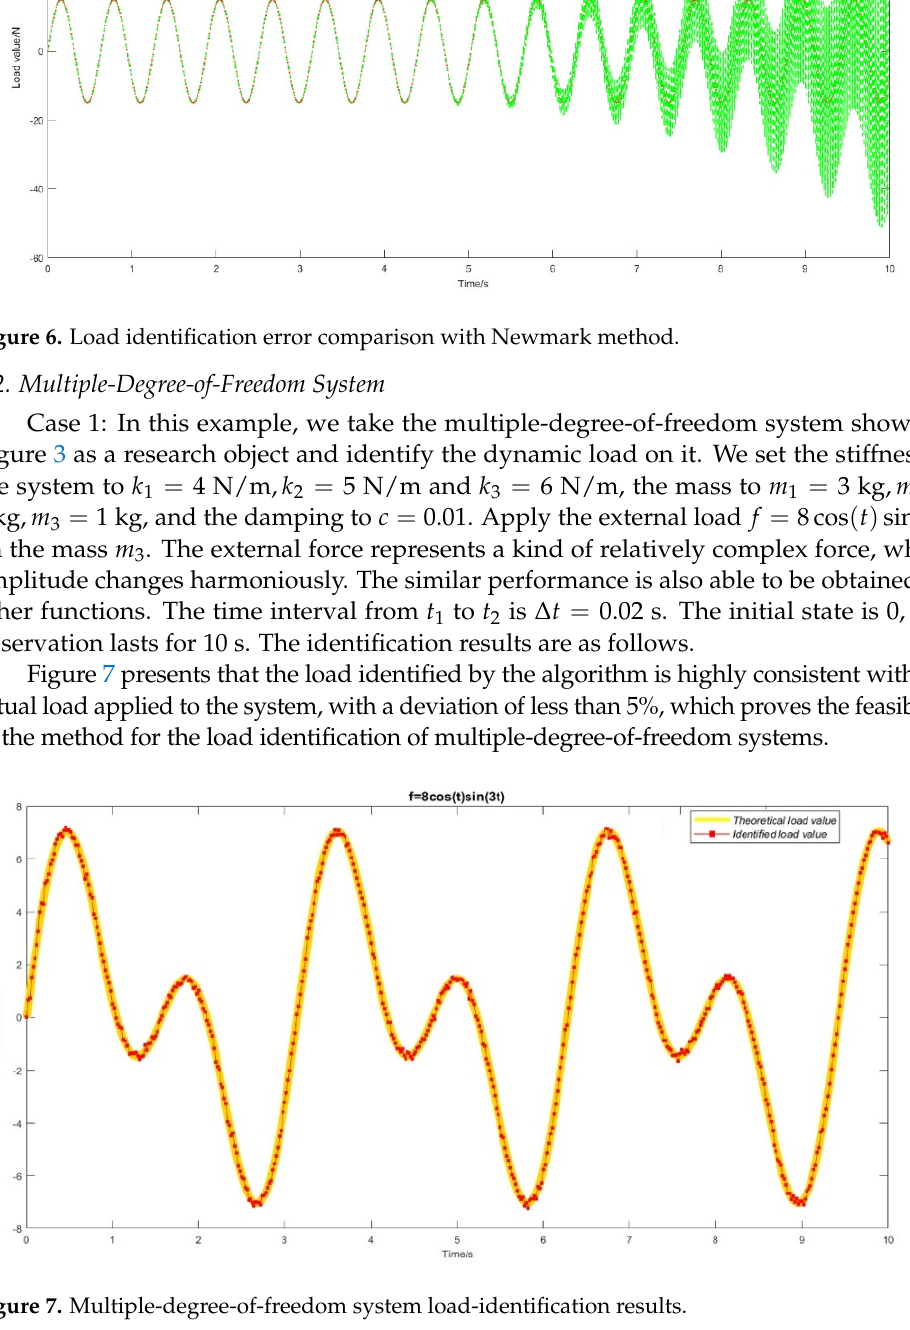
7 of 13 Figure 5. Single-degree-of-freedom system load-identification results.